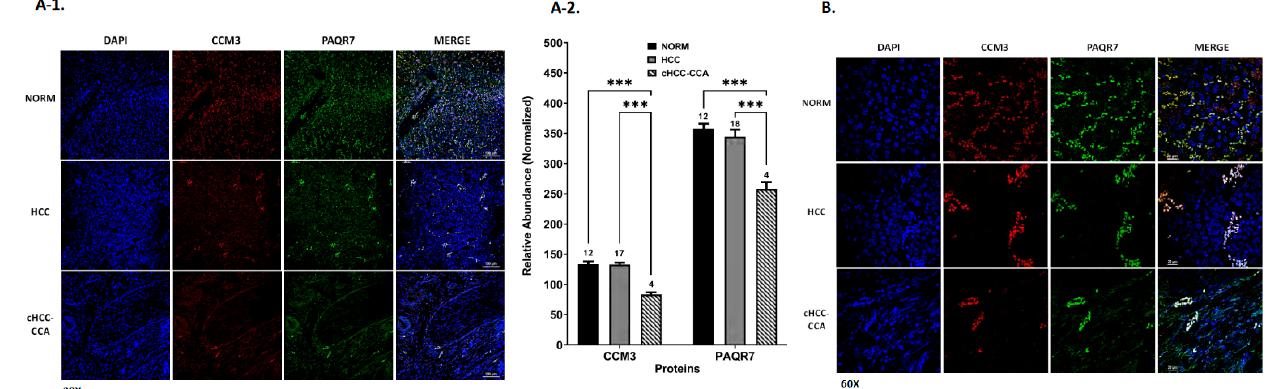
Figure 5. Relative abundance of CCM3 and PAQR7 between HCC and cHCC-CCA subtype. CCM3 and PAQR7 protein expression patterns were measured with immunofluorescence-labeled antibodies, normalized against nuclear staining (DAPI), and quantified using Nikon Elements Analysis software. IF imaging was conducted at 20× (left panels) and 60× magnification (right panels) on NORM, HCC, and cHCC-CCA tissues. ( A-1 ) Representative IF images of CCM3 and PAQR7 protein expression for NORM, HCC, and cHCC-CCA tissues captured at 20x magnification. ( A-2 ) Normalized quantification of CCM3 and PAQR7 for NORM, HCC, and cHCC-CCA tissues. ( B ) Representative 60× IF imaging of areas from panel A to further examine clustering patterns of key CmPn proteins in liver tissues. Sample sizes provided above bar graphs. In all bar plots, *** indicates p ≤ 0.001, using two-way ANOVA.